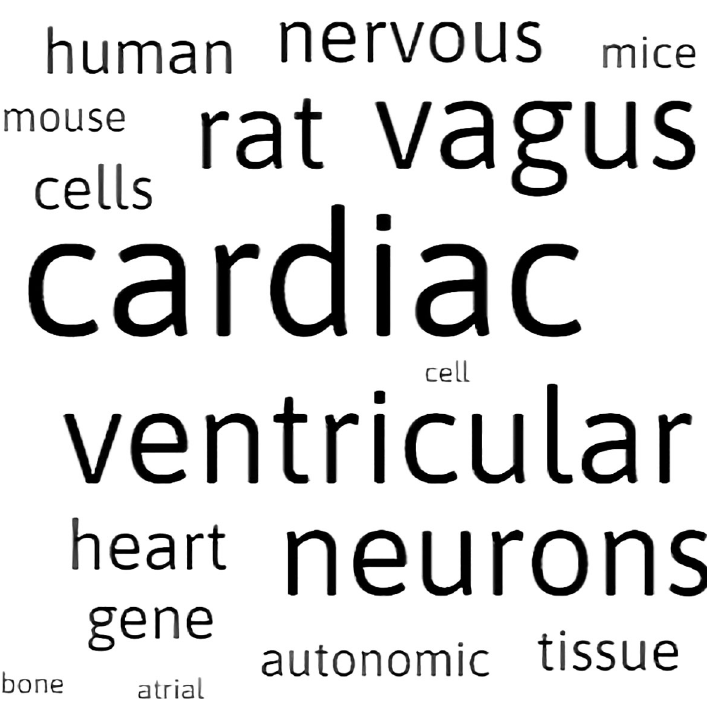
Figure 5. The word maps created by SPARClink are a visual representation of the most significant words shown in the graph-based visualization.